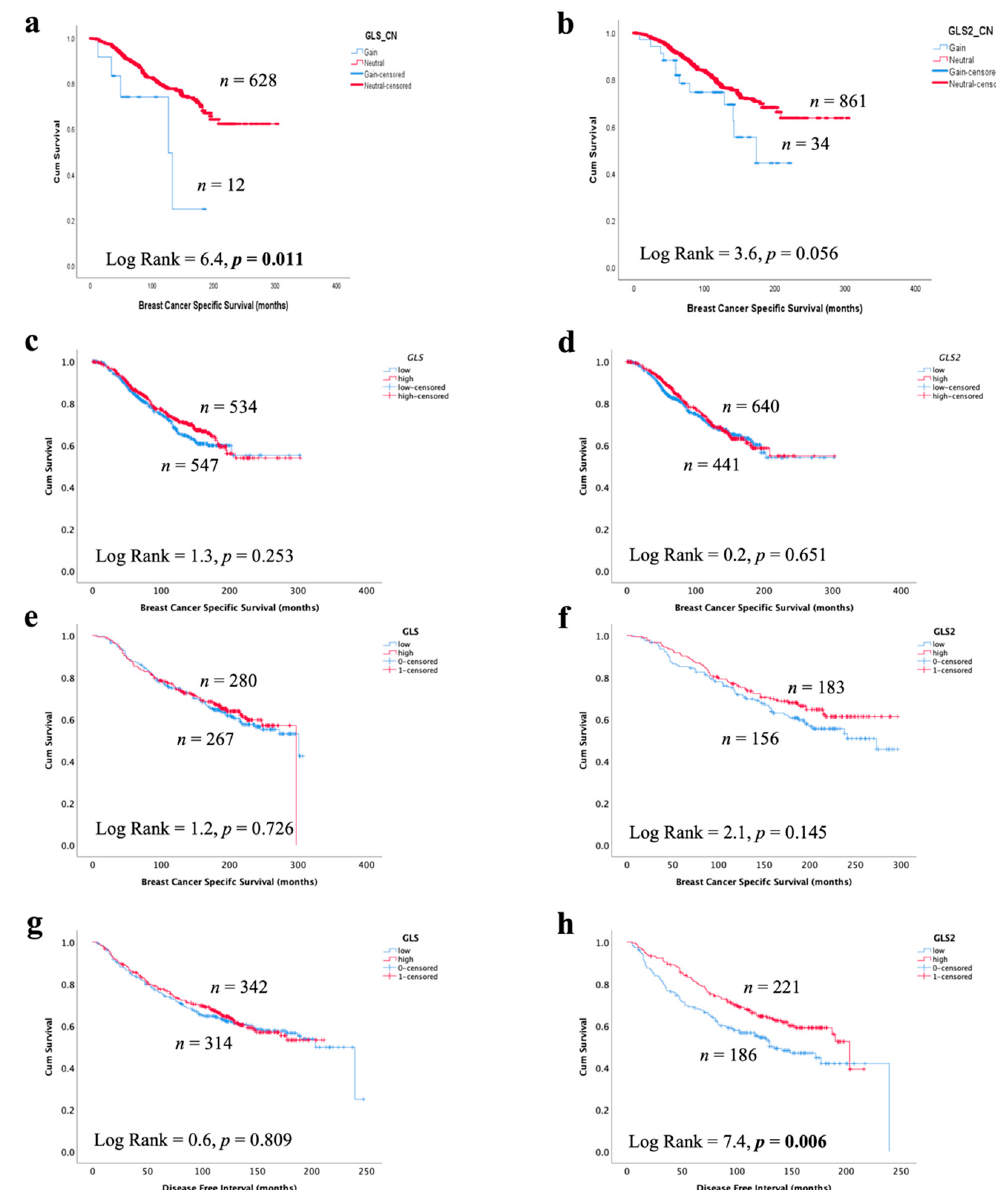
Figure 7. Association of glutaminase expression with patient outcome in ER +/HER2- invasive breast cancer in the METABRIC and Nottingham series: breast cancer-specific survival of ( a ) GLS copy number gain, ( b ) GLS2 copy number gain, ( c ) GLS mRNA, ( d ) GLS2 mRNA, ( e ) GLS protein and ( f ) GLS2 protein, a disease-free interval of ( g ) GLS protein and ( h ) GLS2 protein. Statistically significant p values are in bold .